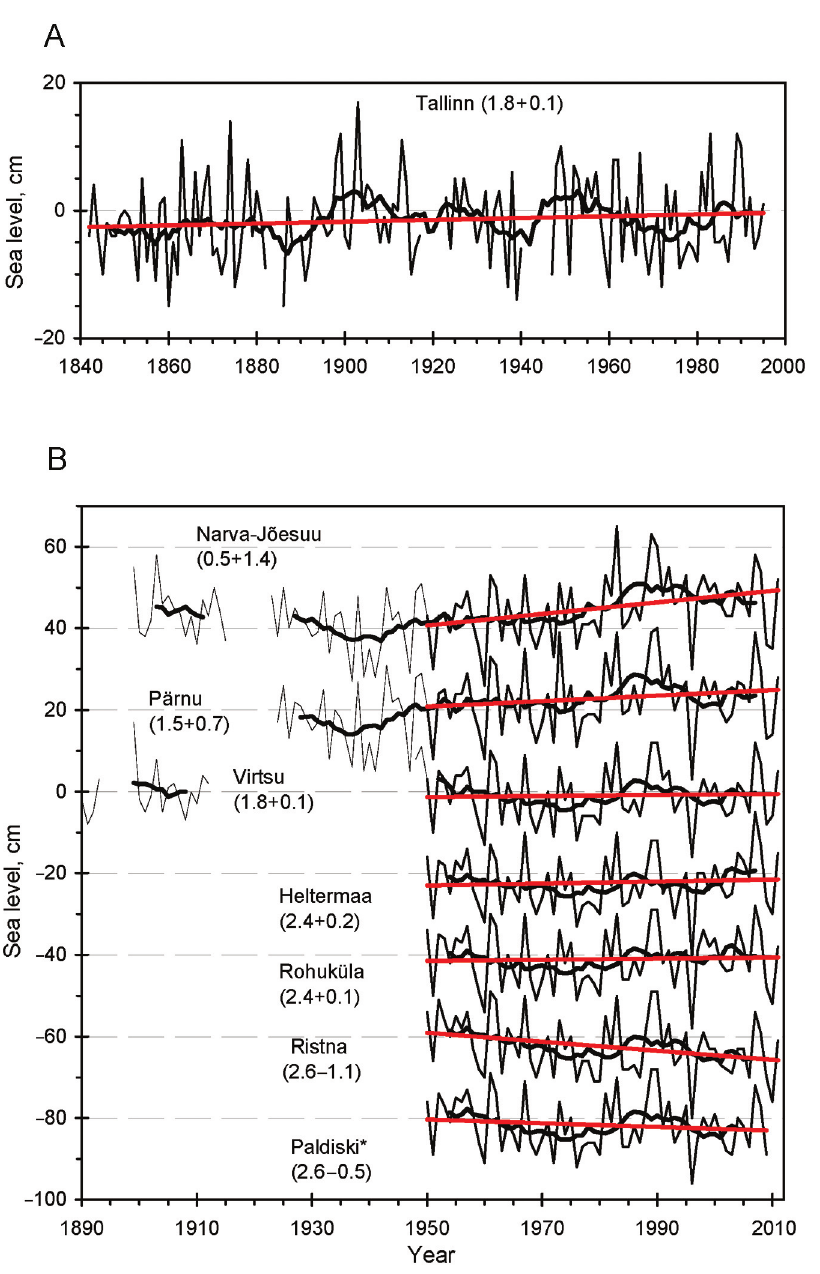
Fig. 4. Variations in annual mean relative sea levels, 11-year moving averages and linear trend lines calculated for the period 19502011 (*Paldiski 19502009). The values of land uplift according to Vallner et al. (1988) and the linear trend slopes of sea level data (in mm yr 1 ) are respectively given in parentheses. For better viewing, the data of different tide gauges are shifted by 20 cm regarding each